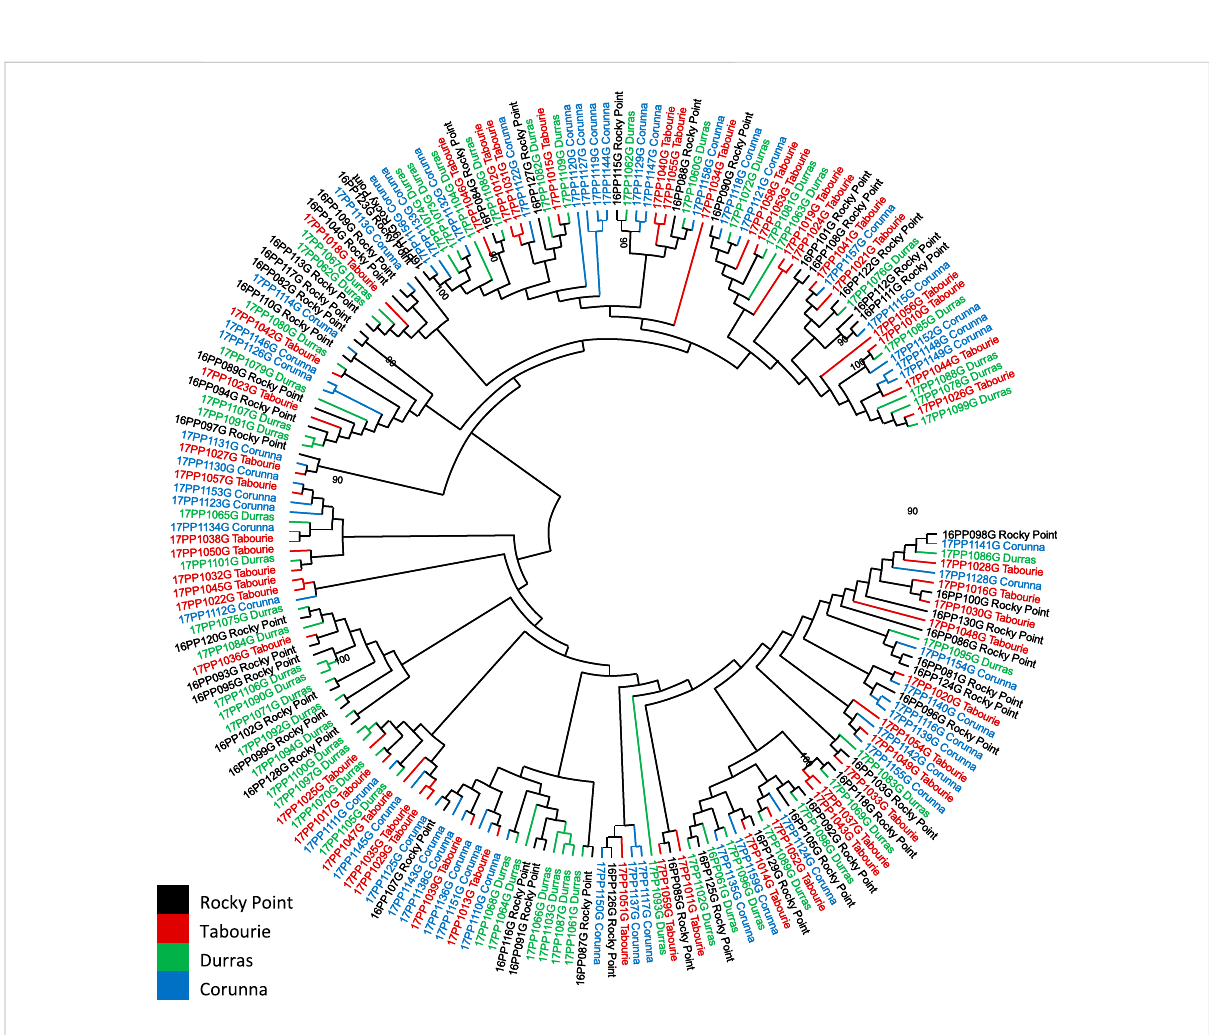
FIGURE 3 Phylogenetic analysis oftheeasternkingprawn mtCRsequencesfrom fourpopulations collected beforestocking.NosamplesfromWallagoot estuary were available before stocking. Analysis was conducted using maximum likelihood method using GTR + G = I model in MEGA11 (Tamura etal.,2021).Eachsampleiscolourcodedbasedonthesamplelocation,asindicatedwithintheimage.Onlybootstrapvalues > 90areincludedastext in the fi gure (bootstrap value > 90 offer statistical support for the grouping of the